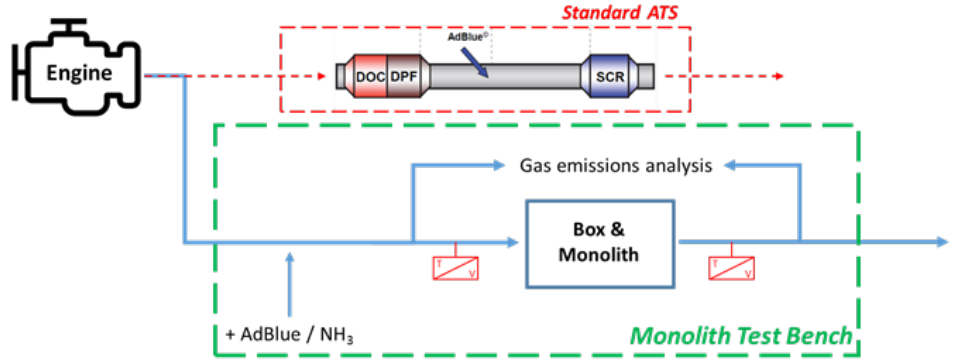
Figure 2. Diagram of the test bench for prototype SCR devices.